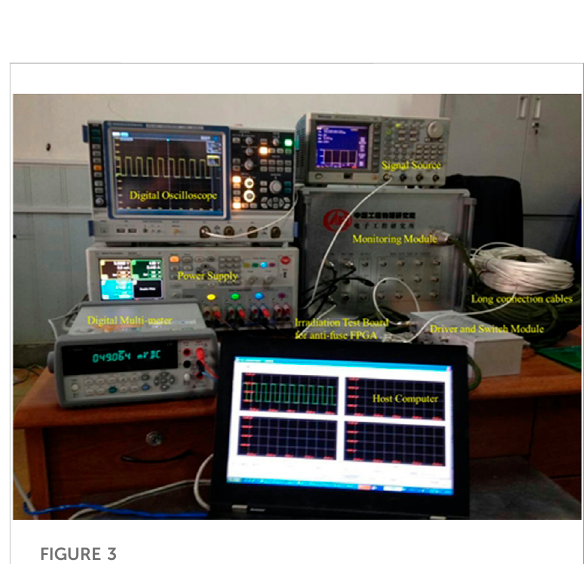
FIGURE 3 Physical connection diagram of detection equipment.